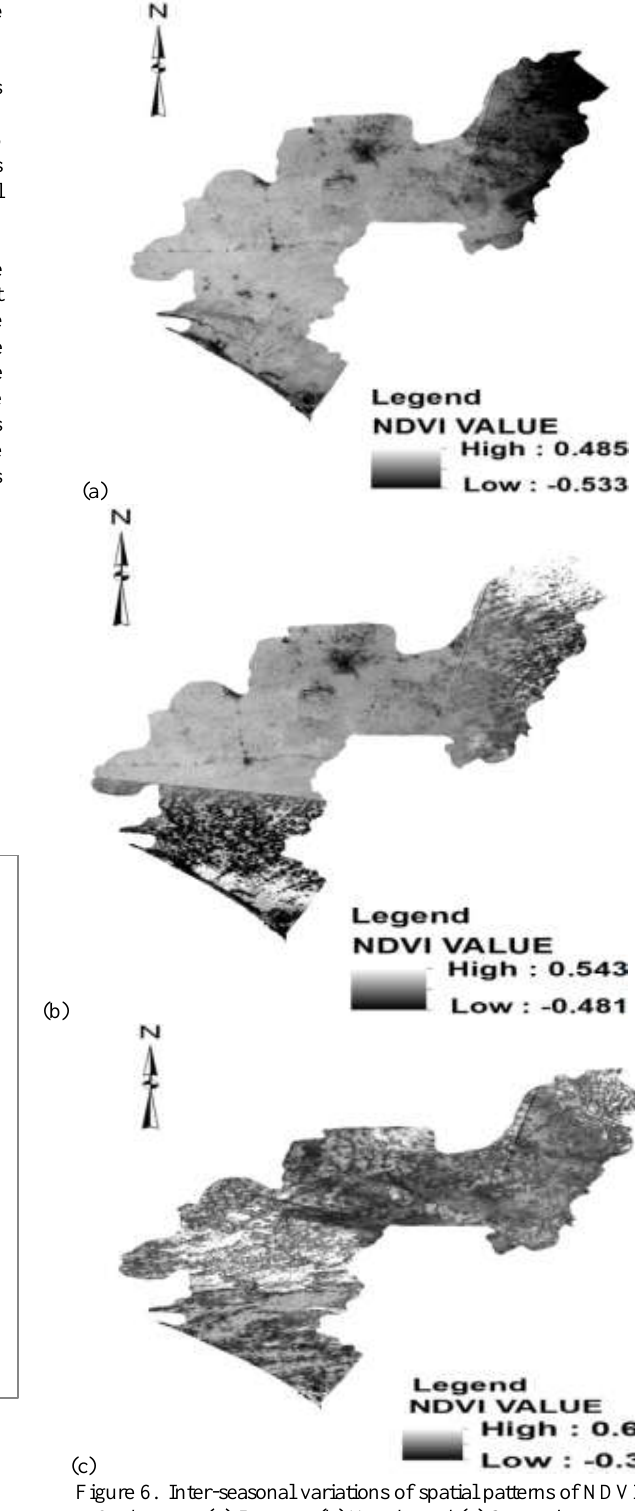
Figure 6. Inter-seasonal variations of spatial patterns of NDVI in Ondo state: (a) January; (b) March; and (c) September.